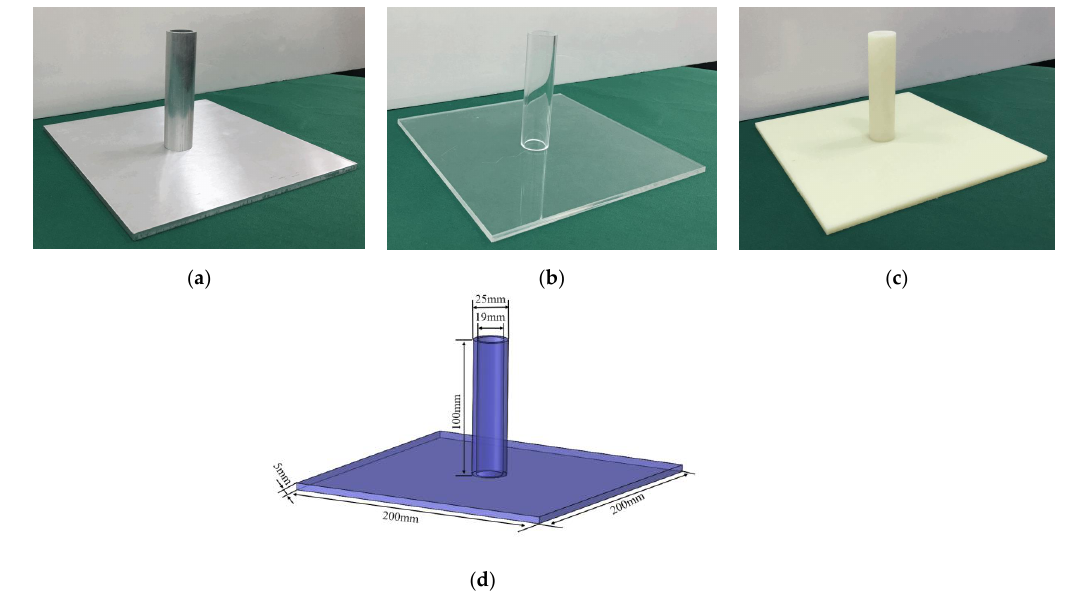
Figure 5. The device for particle accumulation. ( a ) Aluminum alloy material; ( b ) Acrylic material; ( c ) High-density polyethylene (HDPE) material; ( d ) Simulation model.